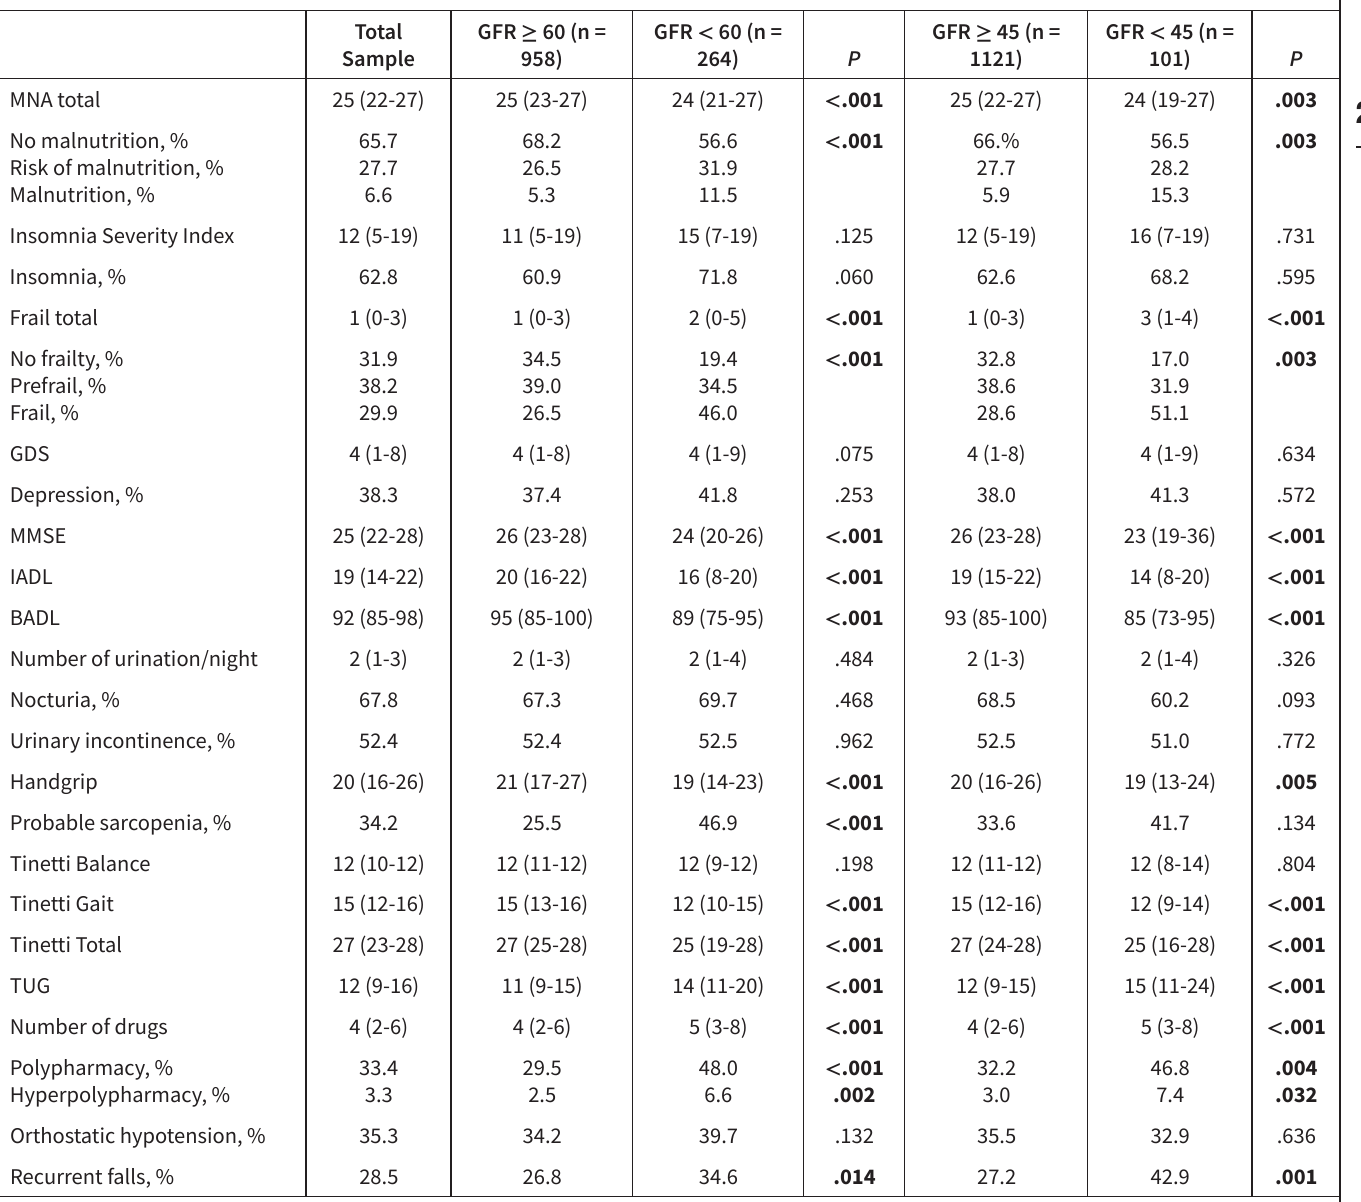
Table 2. Association of Kidney Impairment Defined with Different Glomerular Filtration Rate Cut-Off Values with Comprehensive Geriatric Aassessment